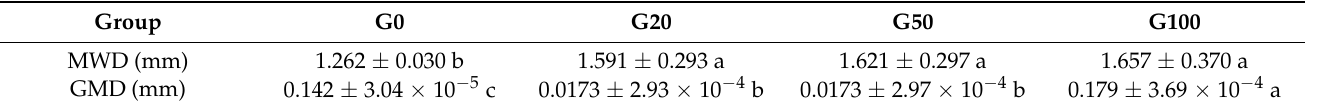
Figure 3. Effect of graphene on soil agglomerates. ( a ) Mean weight diameter (MWD) and ( b ) geometric mean diameter (GMD). Error bars represent the standard error of the mean ( n = 5). The letters a, b, and c indicate a statistically significant difference at p < 0.05 within each group comparison between the treatment. Table 3. Effect of graphene on soil agglomerates.